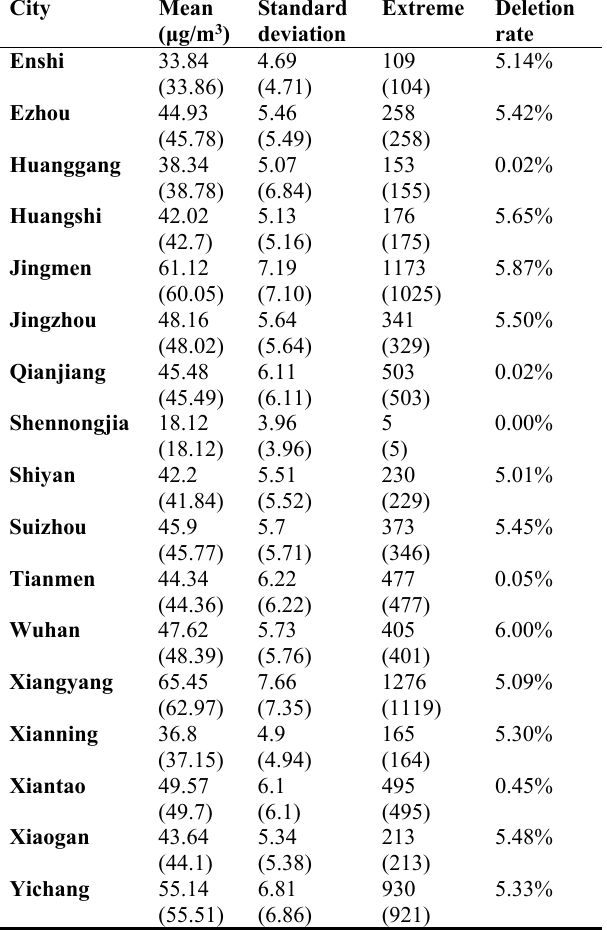
Table 1. Statistical characteristics of PM 2.5 in each city before and after interpolation.